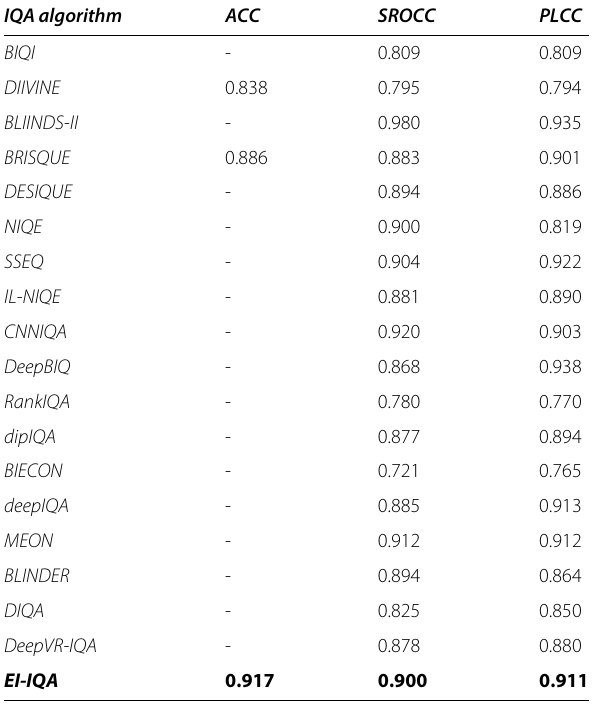
Table 6 Test results on TID2013 database